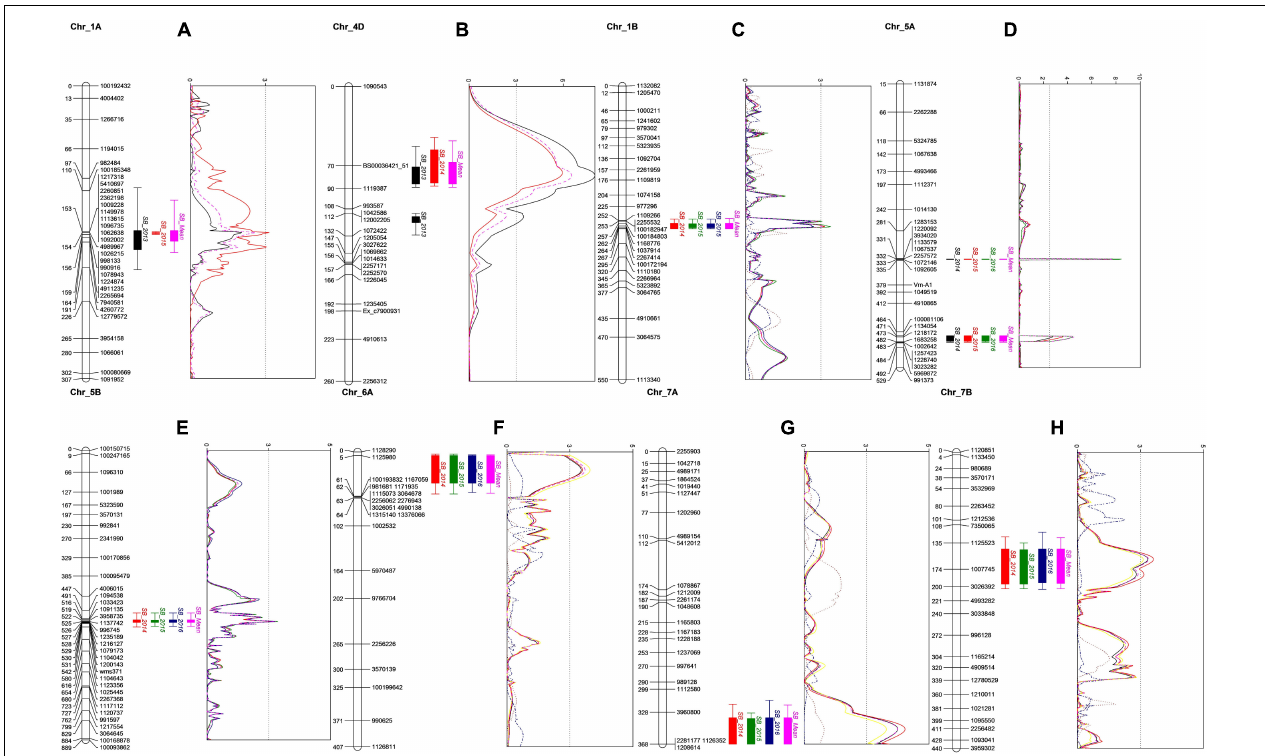
FIGURE 2 | QTL profiles for SB in BC population on chromosomes 1A (A) and 4D (B) , and in CC population on chromosomes 1B (C) , 5A (D) , 5B (E) , 6A (F) , 7A (G) , and 7B (H) . Genetic distance in cM is presented in the left side of each chromosome. A LOD threshold of 2.5 is indicated by the vertical dashed